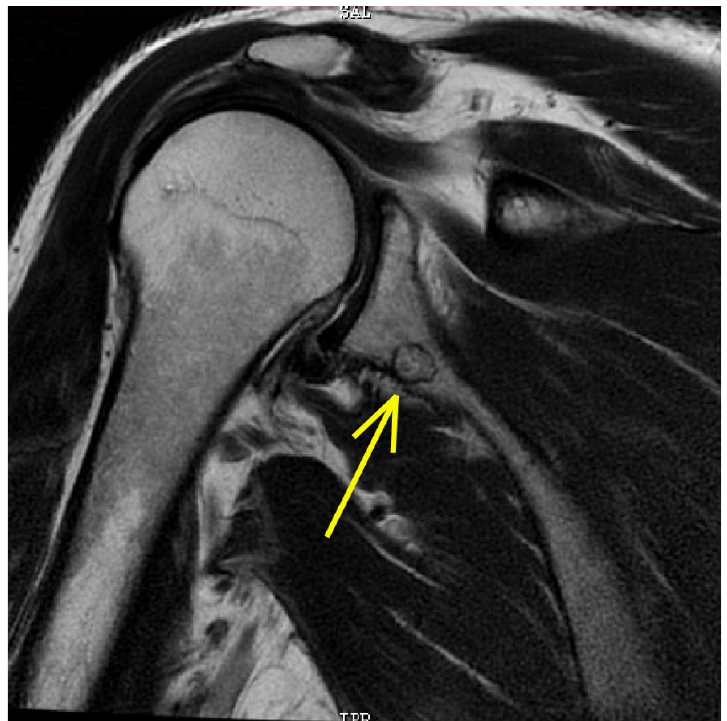
Figure 4. MRI scan. A roundish centimetric formation with a surrounding osteosclerotic border is visible at the lower portion of the scapular neck. This lesion has an uneven signal due to the presence of a central component with intermediate signal intensity (nidus) and is compatible in the first instance with osteoid osteoma with an atypical site (yellow arrow).